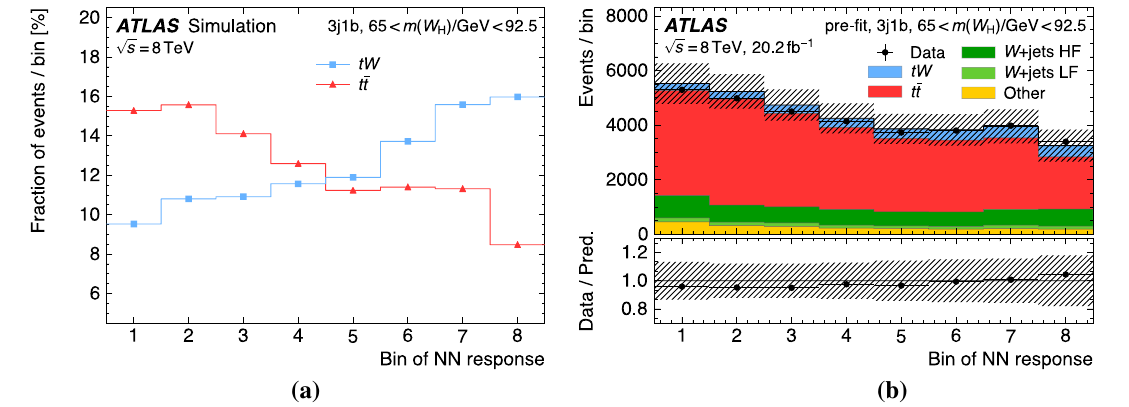
Fig. 4 a Shape of the NN response in the signal (3j1b) region. The distribution contains those events with 65GeV ≤ m ( W H ) ≤ 92 . 5GeV. The distributions for the tW process and the t ¯ t process normalised to unity are shown. b Pre-fit NN output distribution in the 3j1b region. Small backgrounds are subsumed under ‘Other’. The simulated distri-